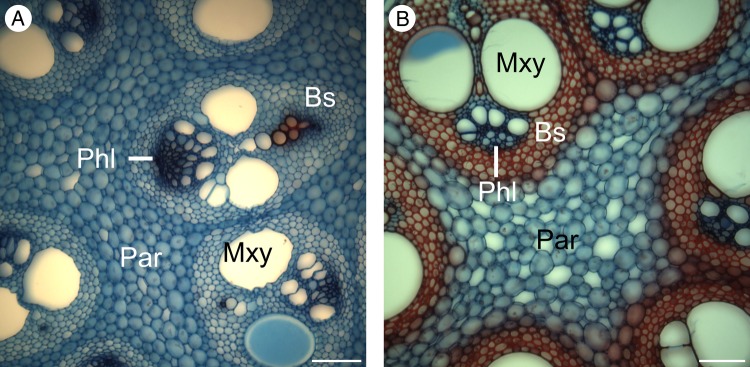
Transverse sections of two developmental stages from central stem regions of F. indica. Differences are not as pronounced as in the peripheral region. (A) Young apical stem sections show low degrees of lignification, with the exception of the protoxylem. (B) Differentiation processes of the central region involve lignification of the bundle sheath and the metaxylem. Par, parenchyma; Phl, phloem; Bs, bundle sheath; Mxy, metaxylem. Scale bars are 100 µm.